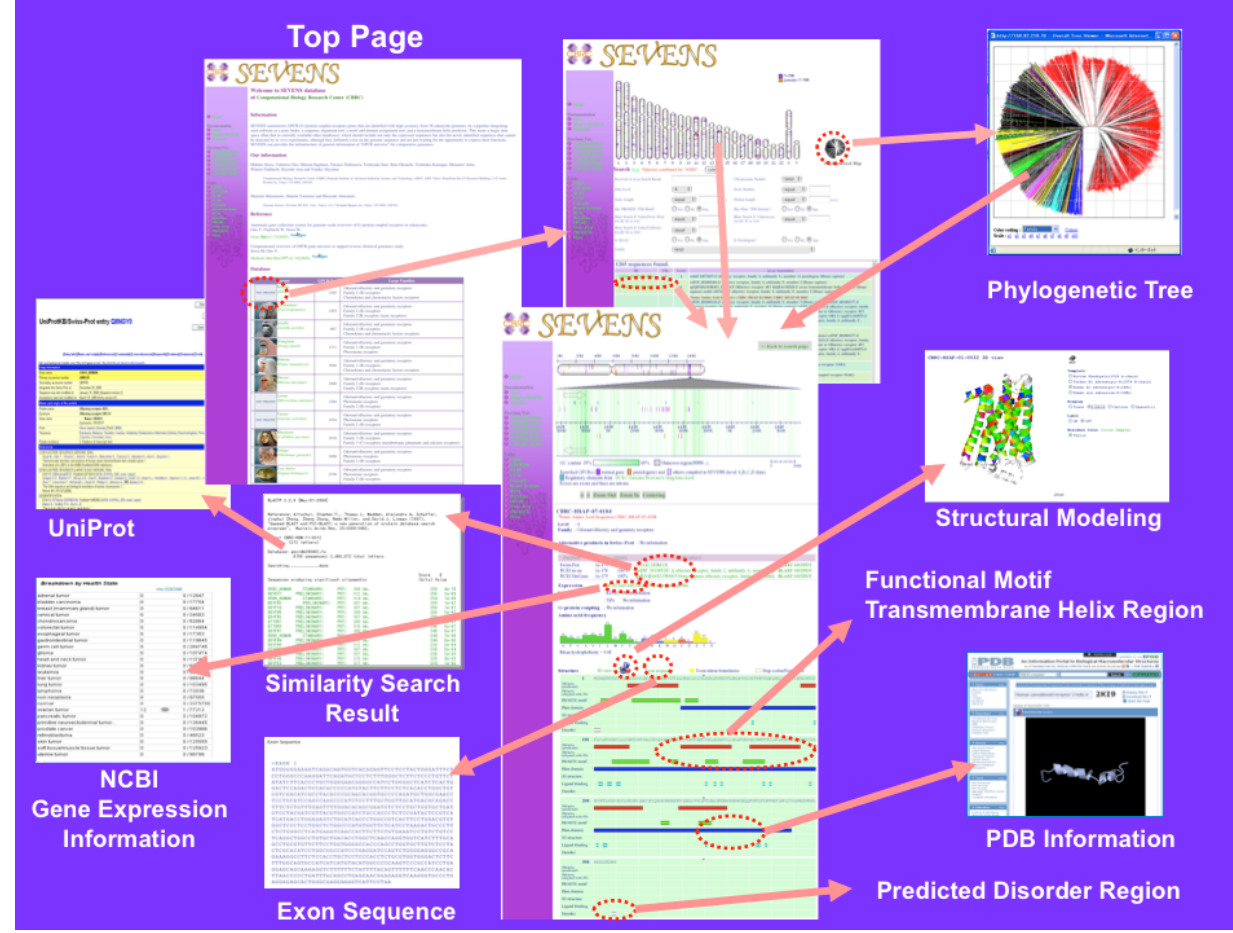
Figure 1. WEB presentation of SEVENS database. By selecting the species on the top